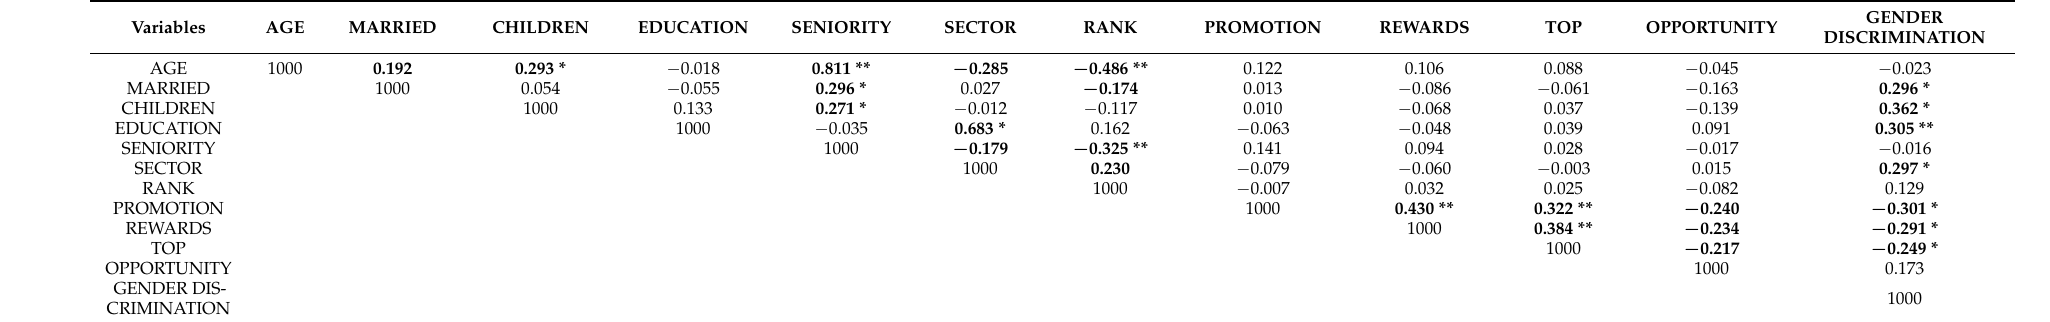
Table 5. Spearman